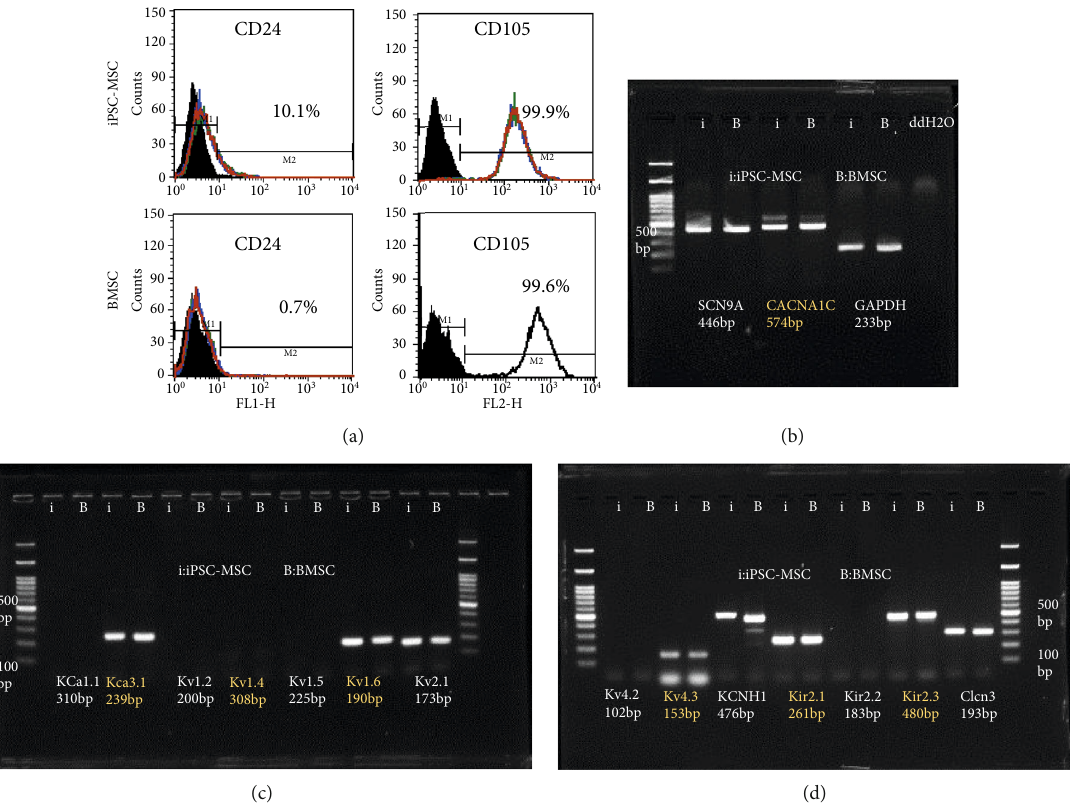
Figure 5: CD24, CD105, and potassium channel expression in iPSC-MSC and BMSC. (a) CD24 and CD105 expressions in iPSC-MSC and BMSC. CD24 was expressed di ff erently between both cells (10% in iPSC-MSC and 0.7% in BMSC). (b – d) RT-PCR showing the potassium channel expressions in iPSC-MSC and BMSC. Both cells expressed potassium channel genes